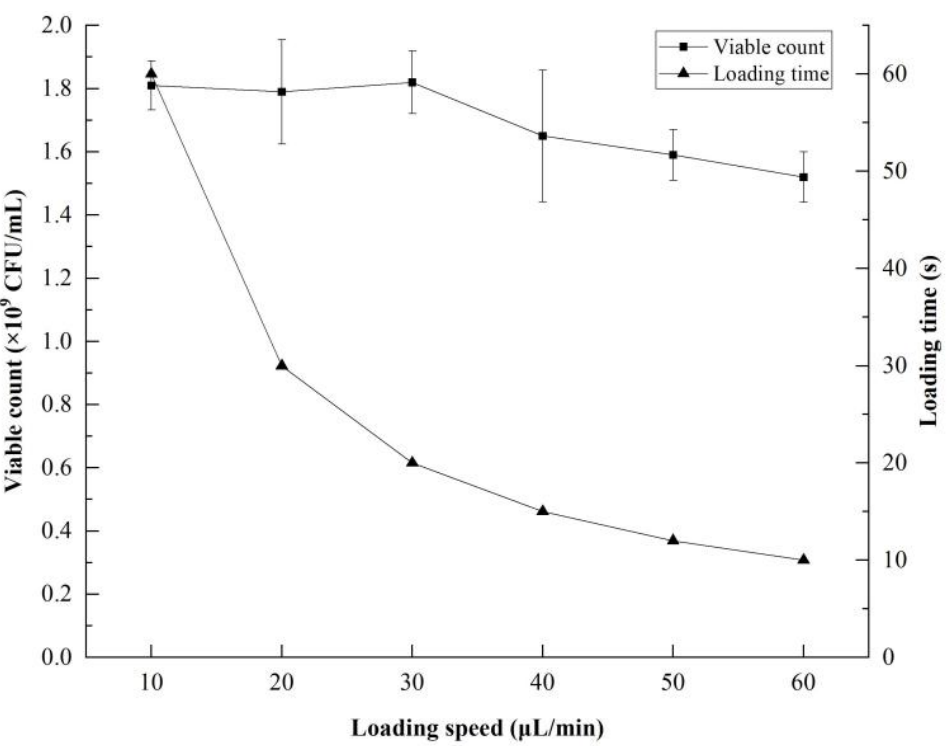
Figure 4. Influence of sample loading speed on the result of viable count detection. Different letters represent significant differences in viable count between different loading speeds. Error bars represent SD.